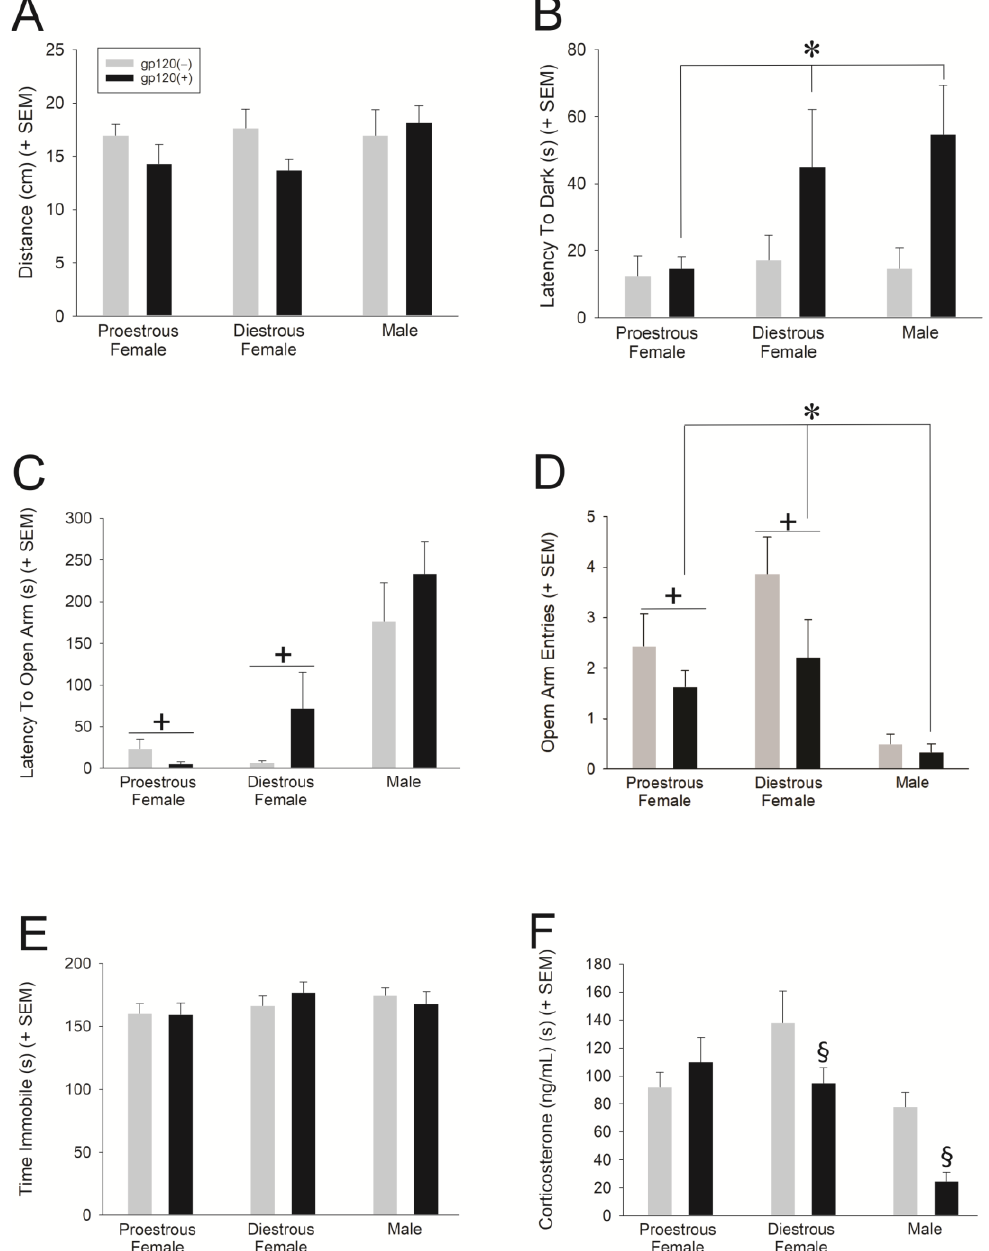
Figure 3. Mice were behaviorally assessed in an open field ( A ), light-dark transition task ( B ), elevated plus maze ( C , D ) and a tail suspension test ( E ). Circulating corticosterone was assessed from whole trunk blood ( F ). * main effect of genotype; + main effect of sex, wherein females are significantly different from males, irrespective of estrous cycle phase; § gp120 × sex interaction, wherein gp120(+) diestrous females and males significantly differ from their respective gp120( − ) controls, p < 0.05. Circulating corticosterone levels were also analyzed via simple linear regression with dependent measures. Among gp120(+) mice, but not gp120( − ) controls, circulating corticosterone negatively correlated with the latency to enter the open arms of an elevated plus maze (Figure 4), indicating reduced anxiety-like behavior when corticosterone is elevated. Notably, older age was also associated with greater circulating corticosterone in gp120(+) mice ( r = 0.53, R 2 = 0.28, p = 0.01), and this relationship was not observed in the gp120( − )